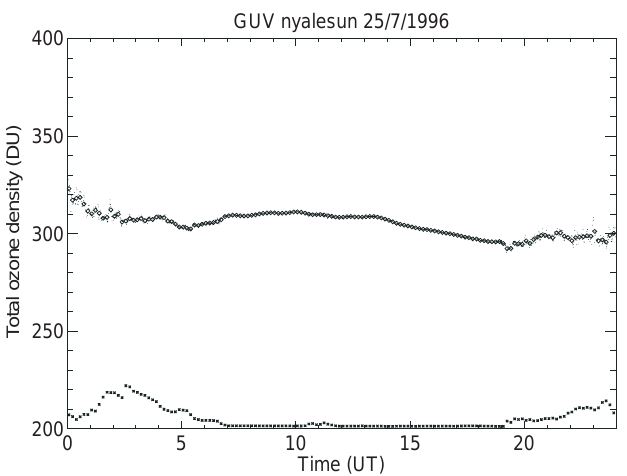
Fig. 10. Total ozone ( upper curve ) and e(cid:128)ective optical thickness + 200 ( lower curve ) as measured by the GUV at Ny-A ˚ lesund on July 25, 1996, (from